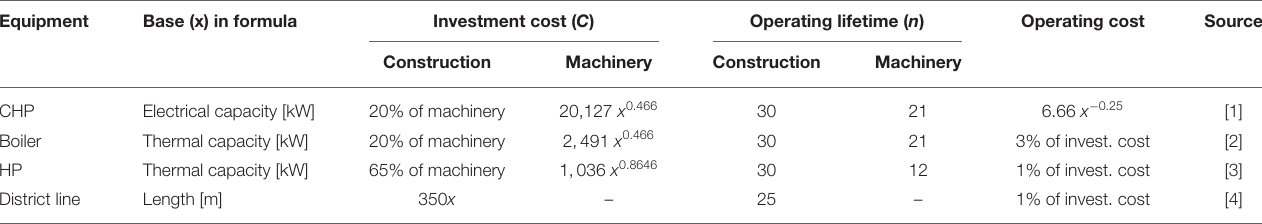
TABLE 4 | Investment costs of relevant equipment.